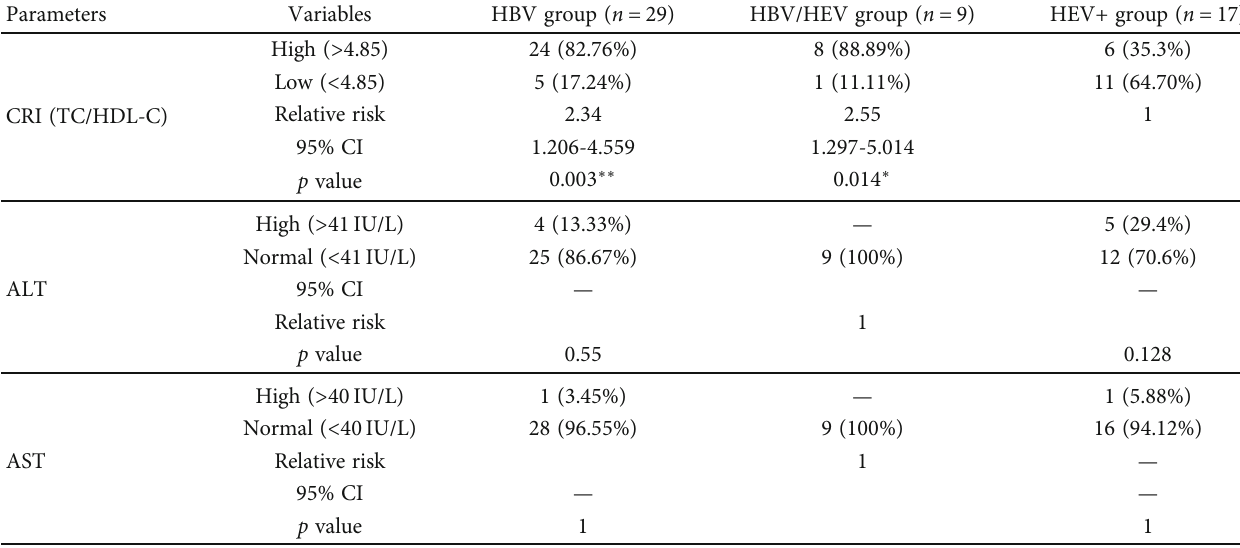
Table 4: Statistical association between coronary risk index frequencies, liver alteration (expressed as high transaminase values), and the mono- and coinfection status.